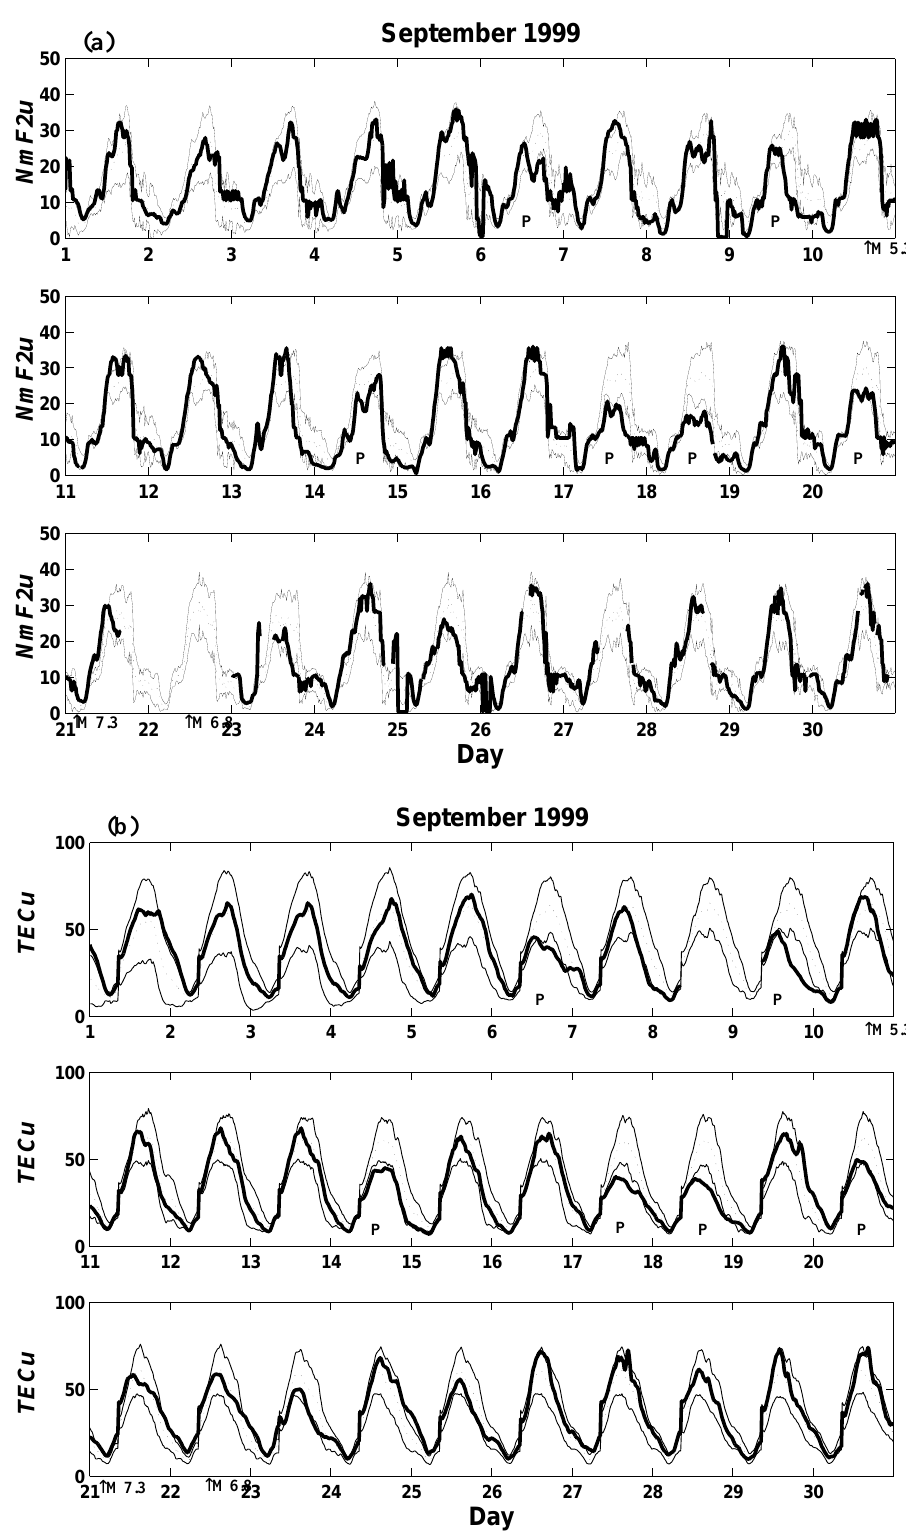
Fig. 2. The variations of Nm F2 and V T EC observed in September 1999. (a) Nm F2 and (b) V T EC . The bold, dashed, solid curves and the P character denote the observed Nm F2 or V T EC , associated 15-day medians, upper/lower bounds and detected seismo-ionospheric anomalies, respectively. 1 Nm F2u = 10 12 el/m 3 and 1TECu = 10 16 el/m 2